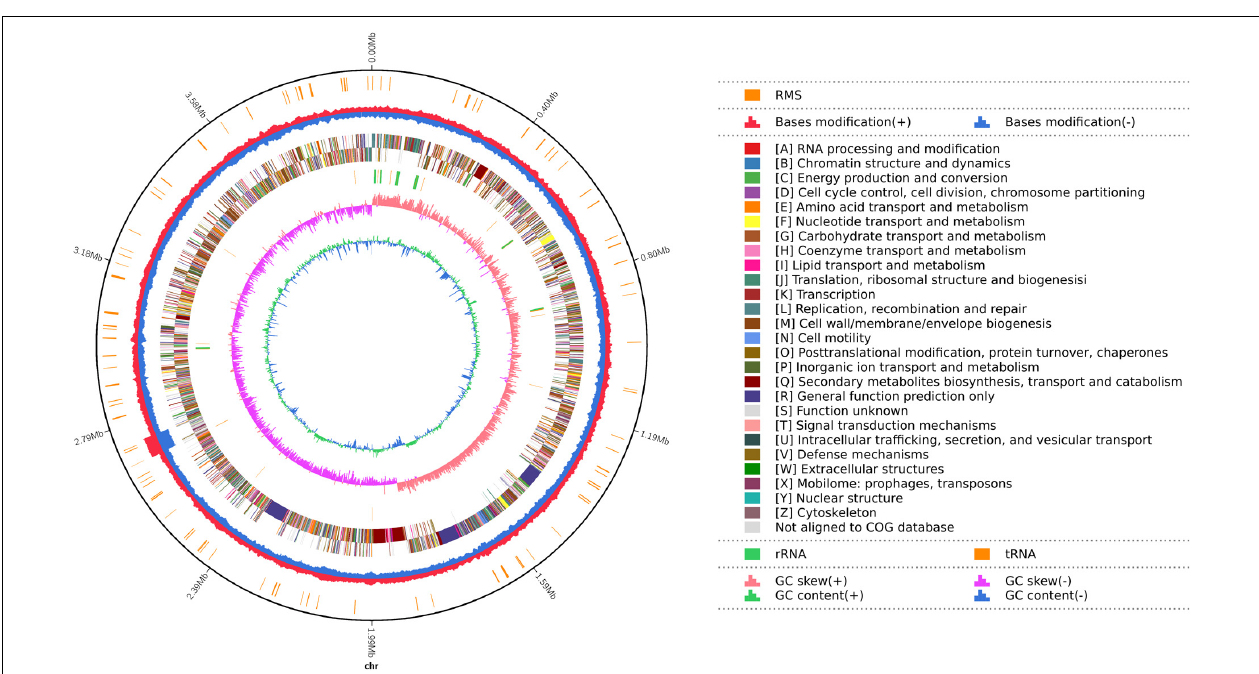
FIGURE 4 | Map of the B. velezensis YB-130 genome. The distribution of circles from outwards to inwards are: ring 1 for genome size (black line); ring 2 for restriction modification system, for forward strand (red) and reverse strand (blue); ring 3 for COG classifications of protein-coding genes on the forward strand and reverse strand; ring 4 for the distribution of tRNAs (brown) and rRNAs (green); ring 5 for GC skew; ring 6 for GC